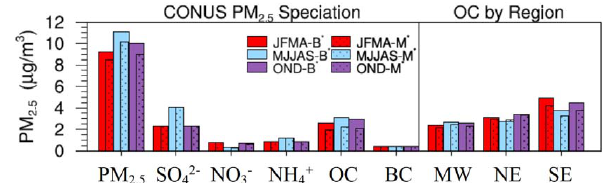
Fig. 7. The annual average of PM 2.5 in the CONUS domain (left), and the annual average organic carbon of PM 2.5 for the Midwest, Northeast, and Southeast.